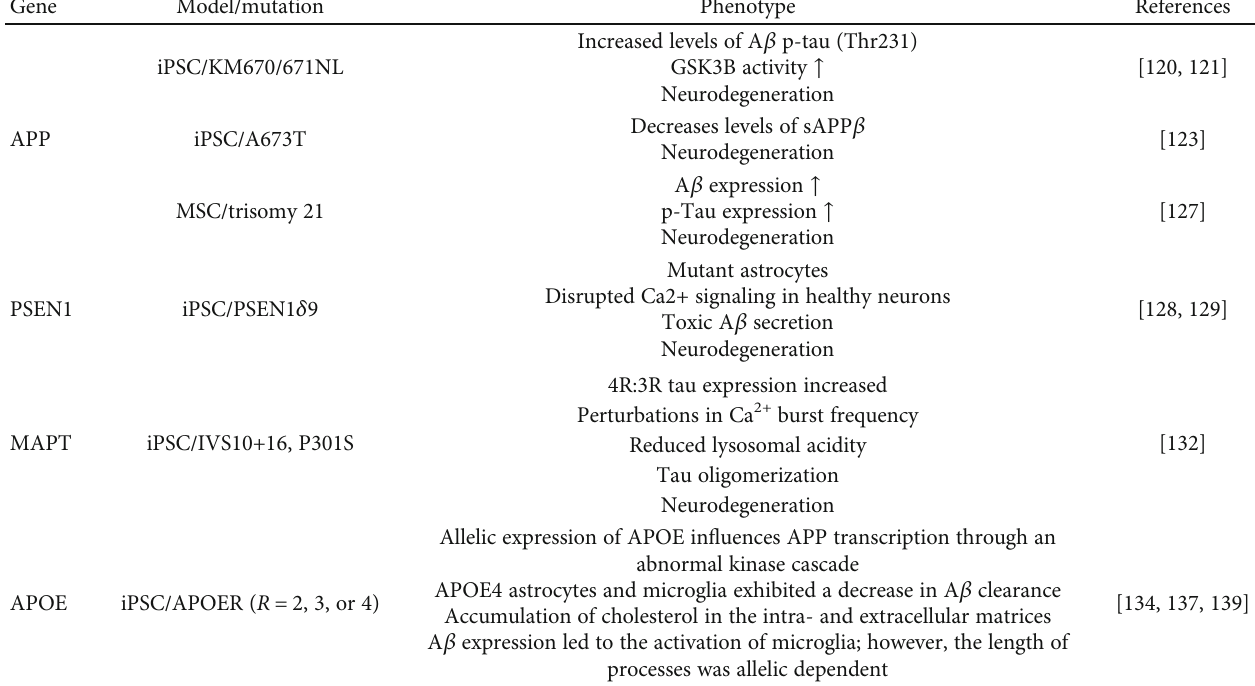
Table 1: Current genetic iPSC models of Alzheimer ’ s